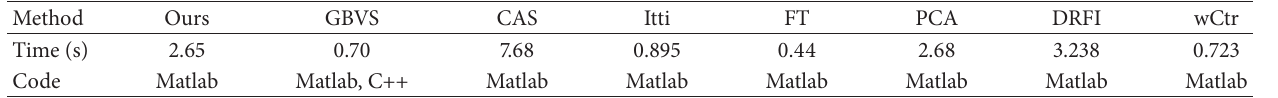
Table 1: Comparison of running